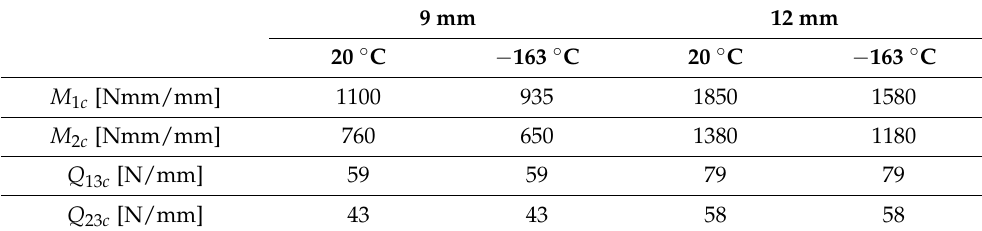
Table 1. The design’s allowable shear and bending strengths for plywood panels